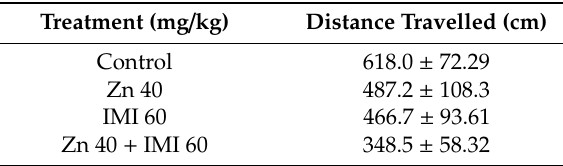
Table 1. E ff ect of treatments on spontaneous locomotor activity in mice. Table 1. Effect of treatments on spontaneous locomotor activity in mice.